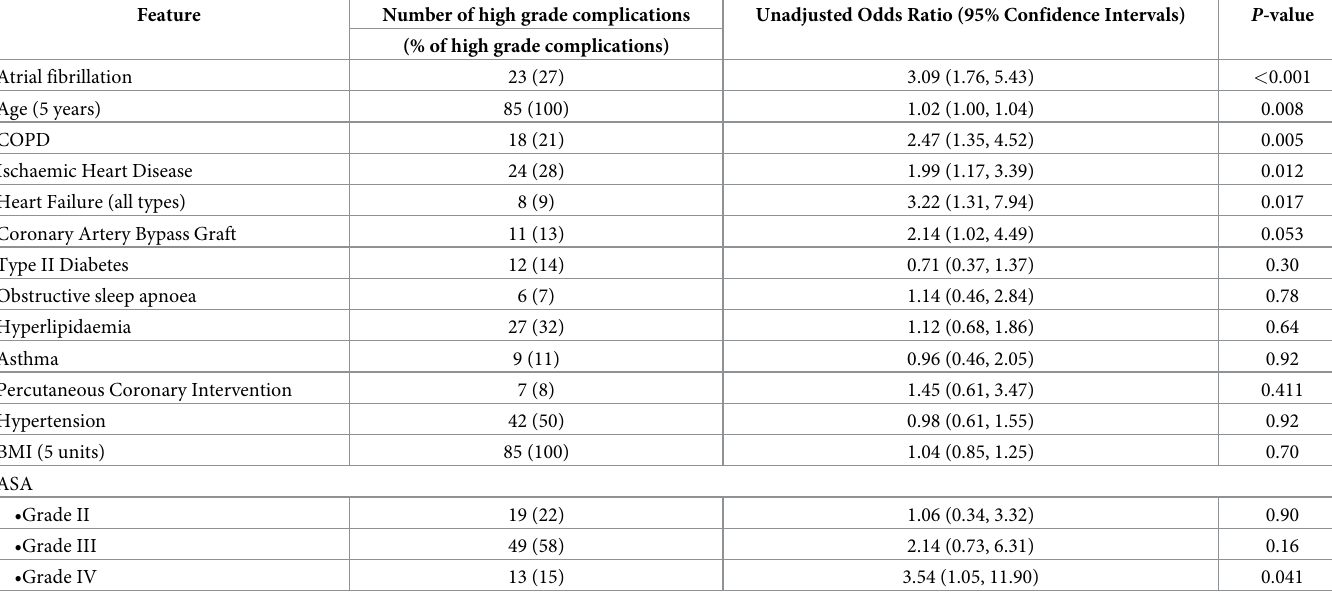
Table 4. Univariate analysis of comorbidities and their association with high grade post-operative complications.